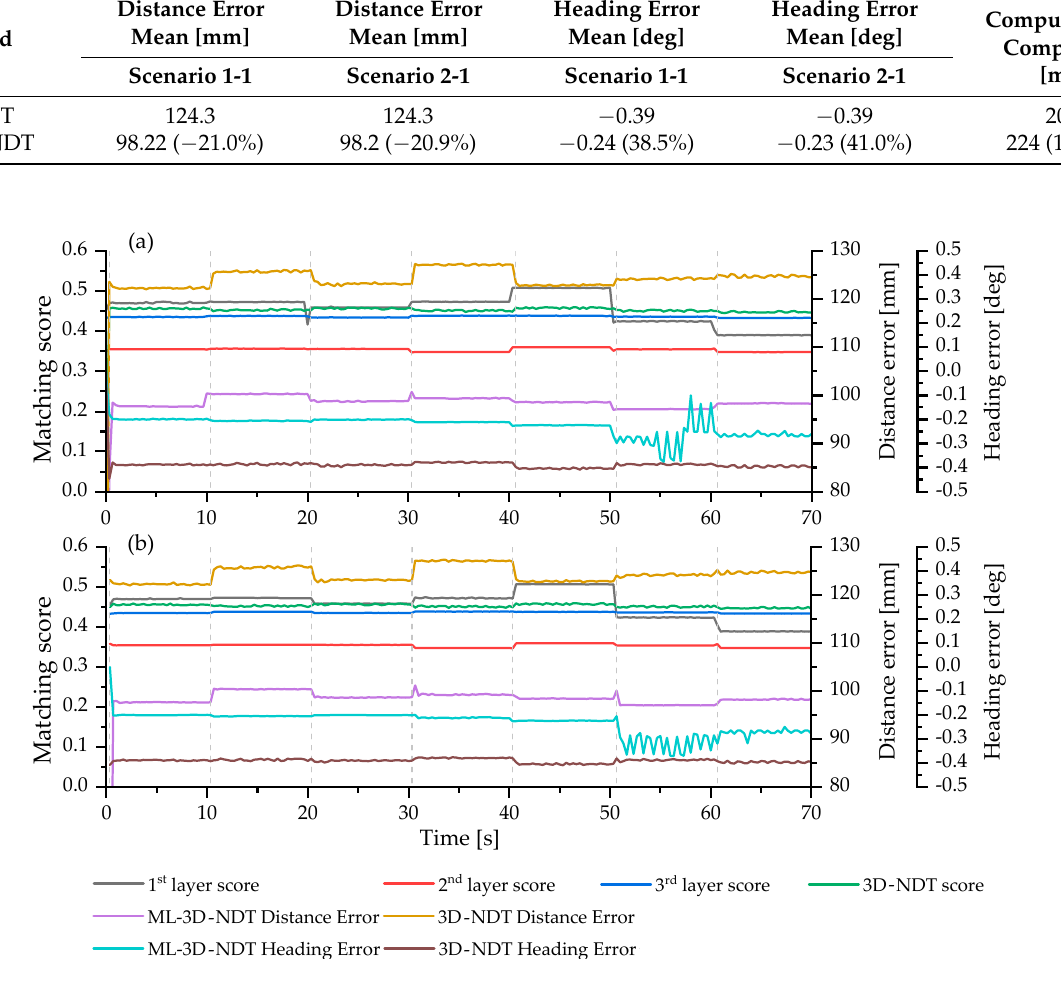
Figure 6. Result of the comparative study in terms of localization accuracy and layer-by-layer scan-matching score: ( a ) scenario 1-1; and ( b ) scenario 2-1. Table 2. Result of the comparative study of 3D NDT and ML 3D NDT in scenario 1-1 and 2-1.